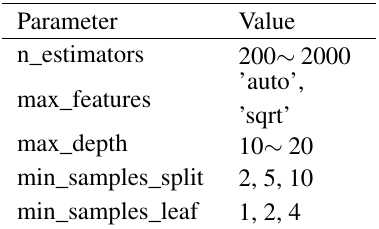
Table 5 Parameter value range